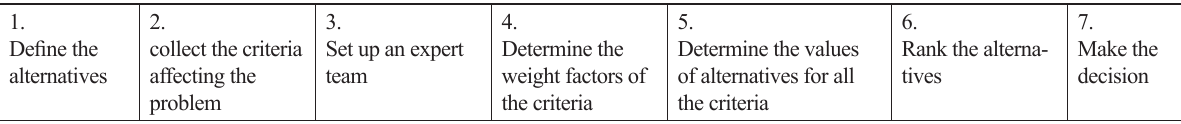
Fig. 1. The proposed dispute resolution framework for delayed construction